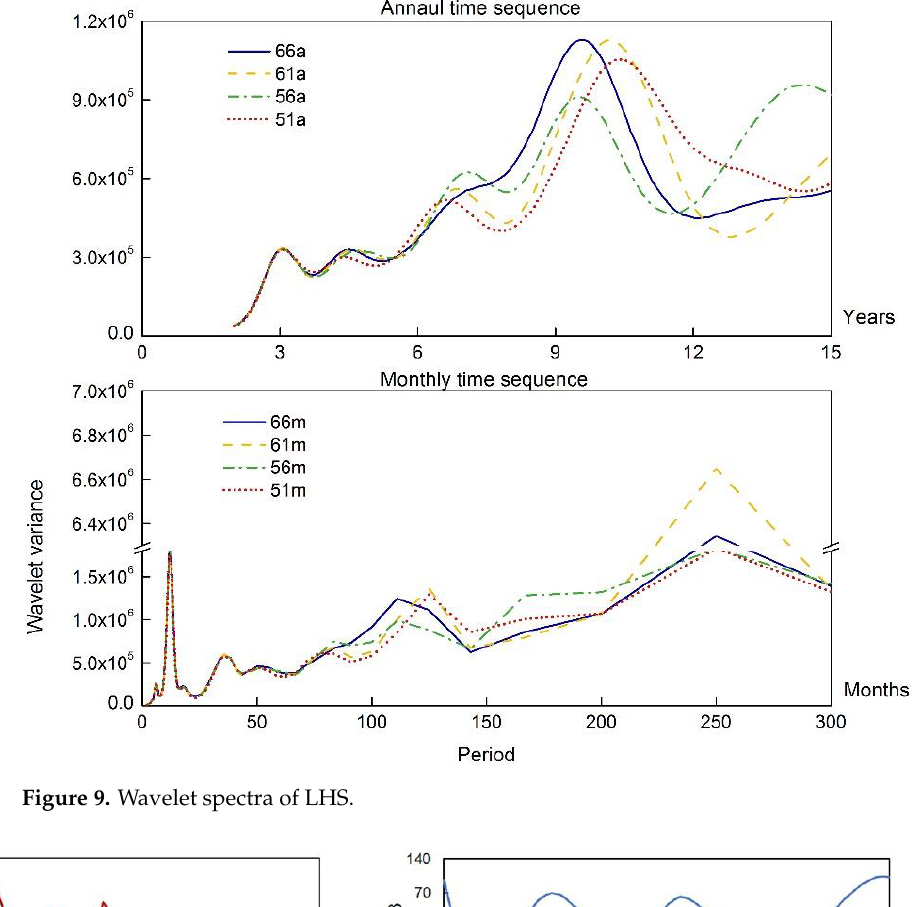
Figure 8. Wavelet spectra of HHS.